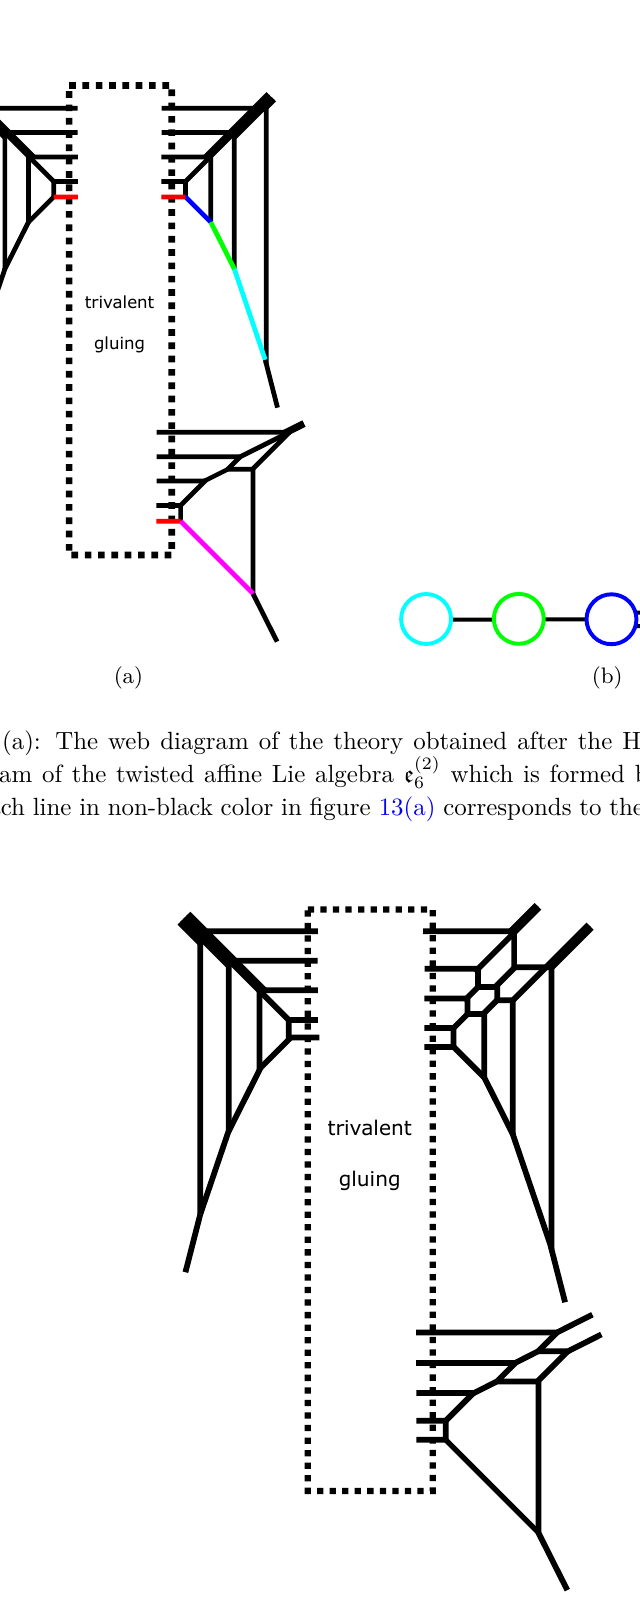
Figure 21. The web diagram of the theory obtained after the Higgsing (4 , (2 , 2) , 0)